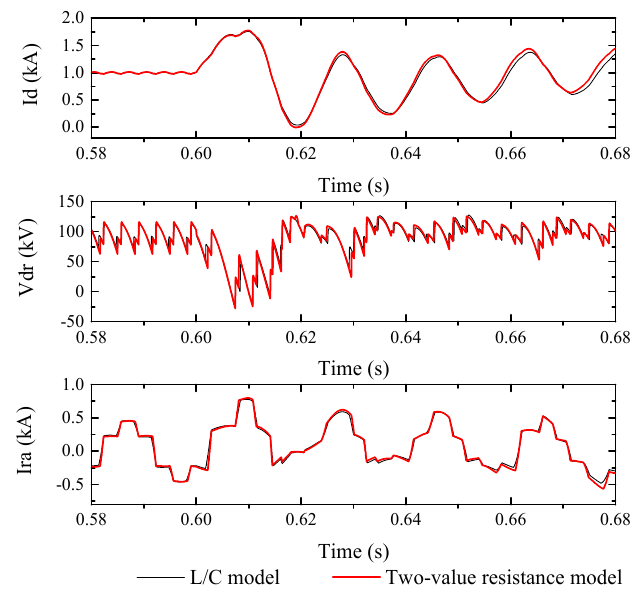
Figure 12. Response of system to a metallic ground fault occurs at the midpoint of DC transmission line. ( Top ) rectifier DC current, ( middle ) rectifier DC voltage, ( bottom ) rectifier AC current (Case 2).